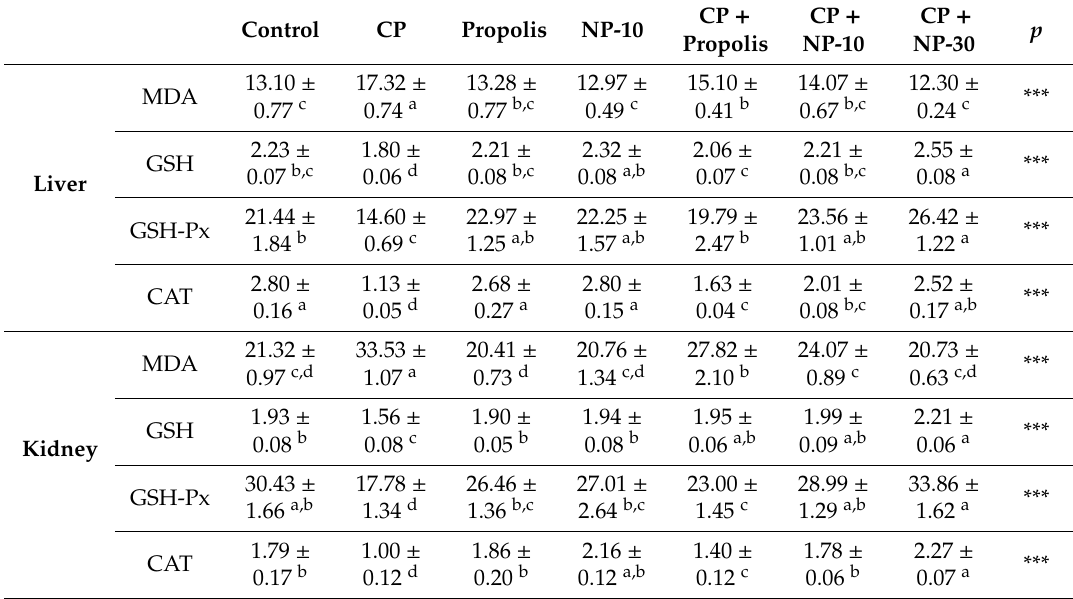
Table 3. E ff ects of propolis and nano-propolis on MDA (nmol / g), GSH (nmol / g), GSH-Px (IU / g protein), and CAT (kU / g protein) values in the liver and kidney tissues of the experimental groups (Mean ±